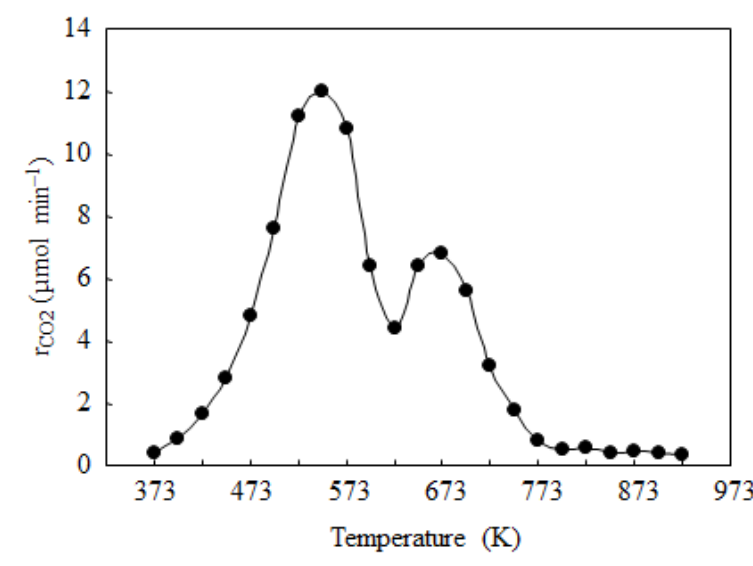
Figure 10. CO 2 formation from carbonaceous deposits over the 7.7 wt. % Co/CeO 2 (hp) catalyst after reaction at 673 K for 120 h.